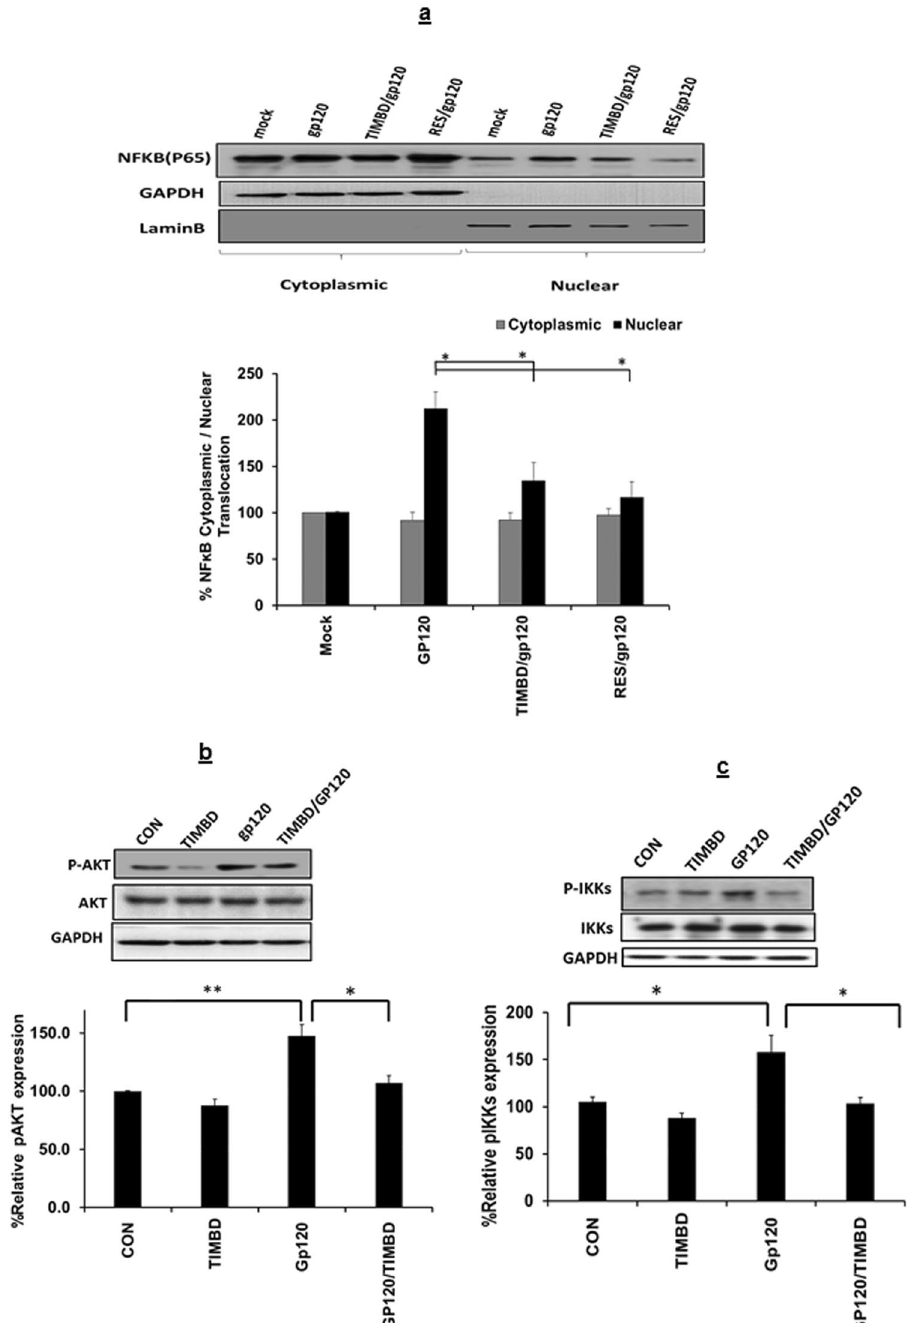
Figure 5. TIMBD suppresses IKKs and AKT phosphorylation and NFĸB-p65 translocation in SVG astrocytes. SVG astrocytes were treated with 50 µ M TIMBD 1 h prior to transfection with plasmid encoding HIV-1 gp120 for 6 h. The presence of NFĸB-p65 subunit in the cytoplasm and the nucleus was determined ( a ). SVG astrocytes were treated with 50 µ M TIMBD 1 h prior to treatment with 50 ng/ml recombinant gp120 proteins for 10 minutes. The protein expression levels of phosphorylated IKKs ( b ) and AKT ( c ) were determined using western blotting. GAPDH was used as loading control for cytoplasmic while Lamin-B was used as loading control for nuclear extracts and were used to normalize protein expression levels. The blots represented in the figures were obtained by cutting the membranes at molecular weight markers covering protein of interest before probing them with primary and secondary antibodies. Each bar represents mean ± SE for 3 independent experiments, with each experiment done in triplicate. One-way Anova was used for statistical analysis and statistical significance is denoted as * (p-value ≤ 0.05) and ** (p-value ≤